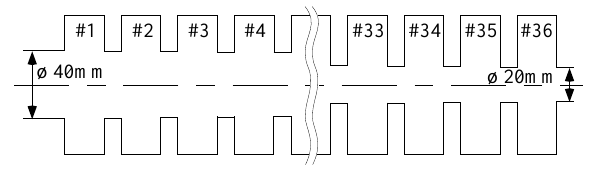
FIG. 1. Shape of the 36-cell test